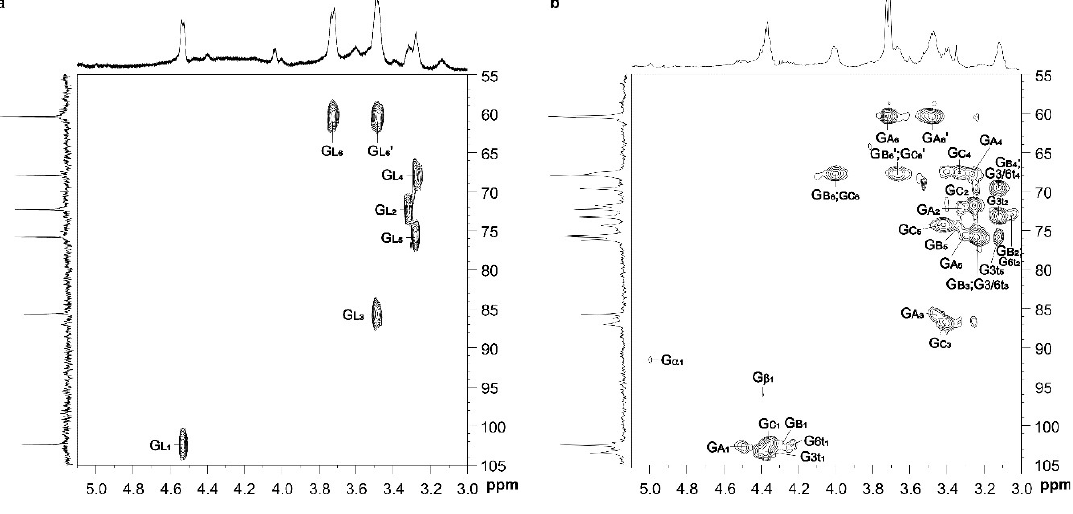
Figure 4. HSQC spectra (400 MHz, Me 2 SO- d 6 , 70 °C) of GW-p ( a ) and GW-s ( b ). G L and G A correspond to [ → 3)-β- D -Glc p -(1 → ], and G B , G C, G 3t , G 6t , G α , and G β correspond to [ → 6)-β- D -Glc p -(1 → ], [ → 3,6)-β- D - Glc p -(1 → ], [β- D -Glc p -(1 → 3], [β- D -Glc p -(1 → 6], [ → 3)-α- D -Glc p ], and [ → 3)-β- D -Glc p ] residues, respectively.